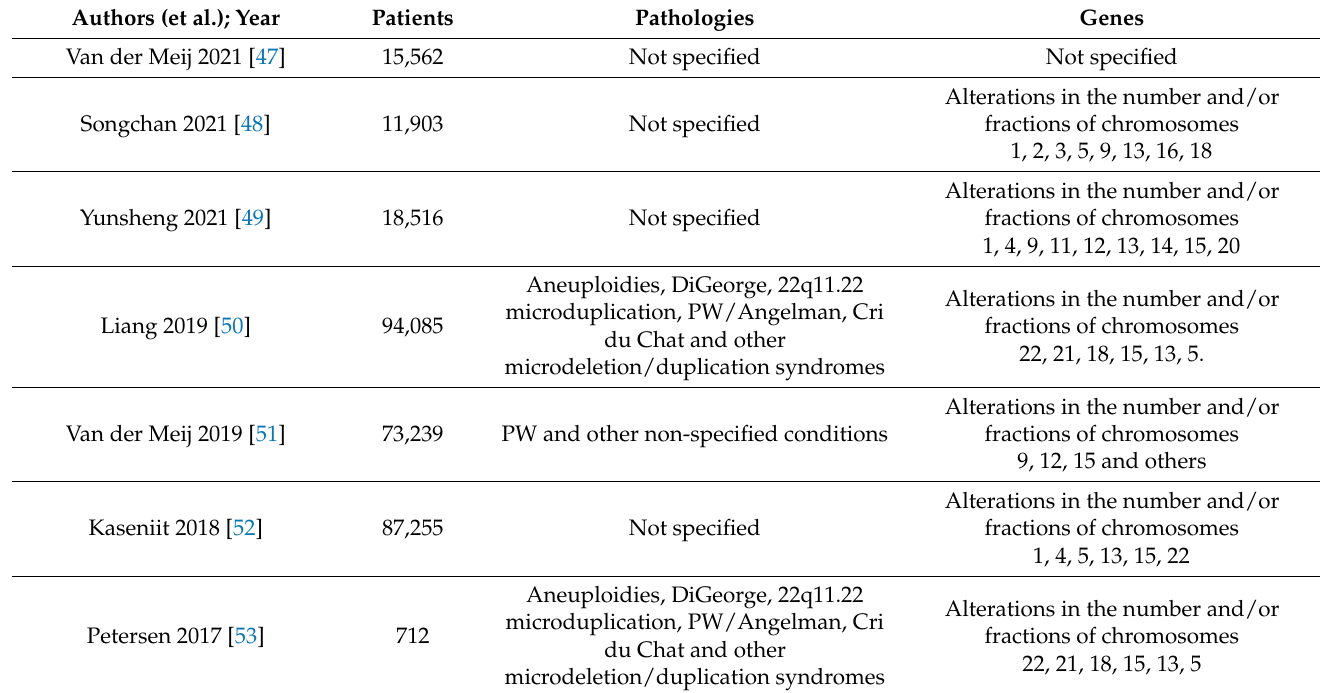
Table 2. Non-invasive prenatal diagnosis of copy number variation pathologies in studies included in the review. Most of these anomalies, and therefore of the pathologies related to them (in the case of pathogenetic variants), arise sporadically; cases of inheritance are